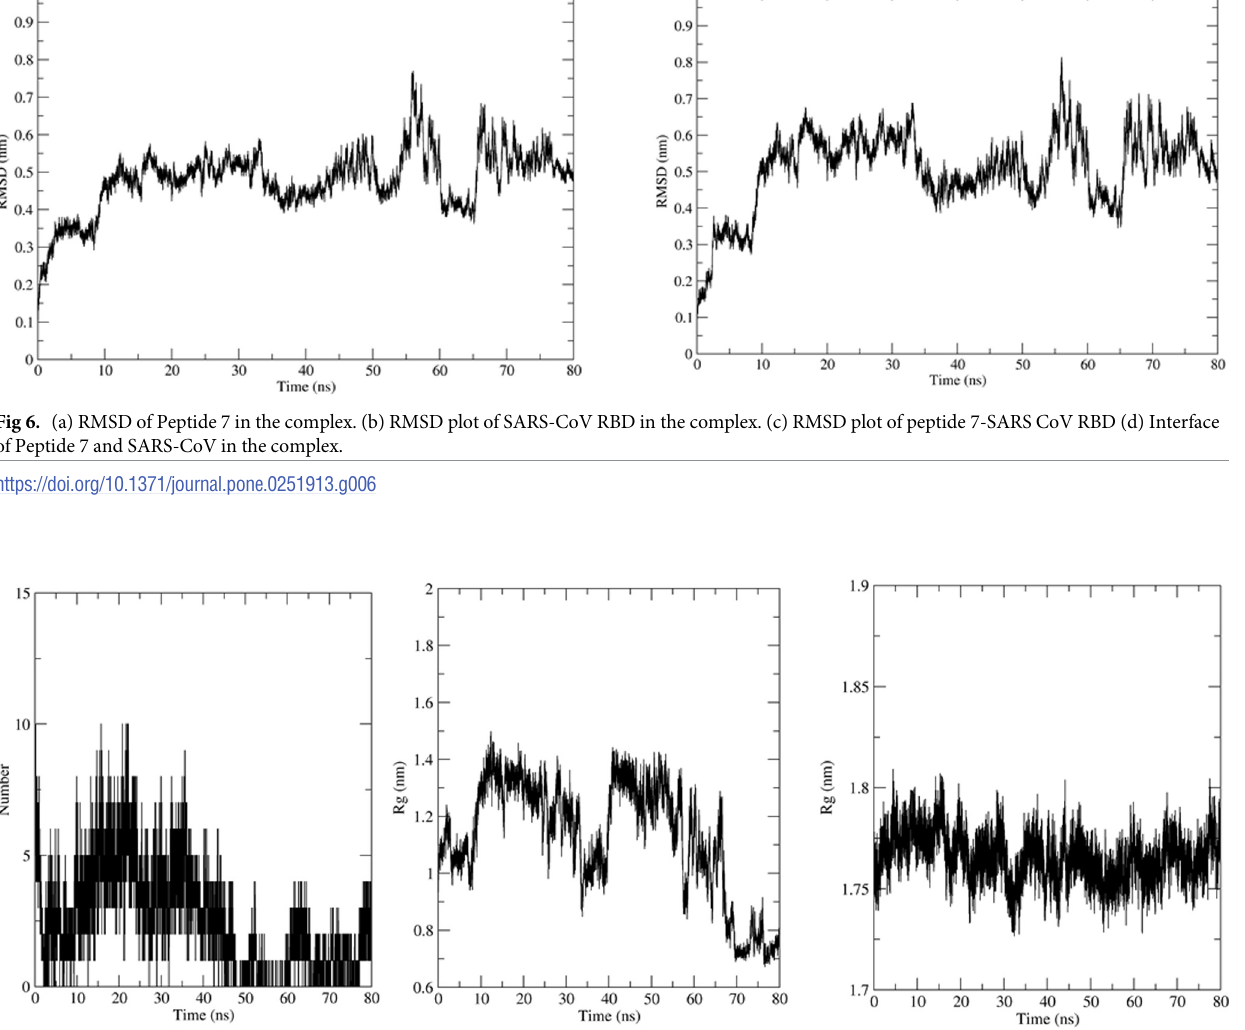
PLOS ONE | https://doi.org/10.1371/journal.pone.0251913 May 18, 2021 8 /